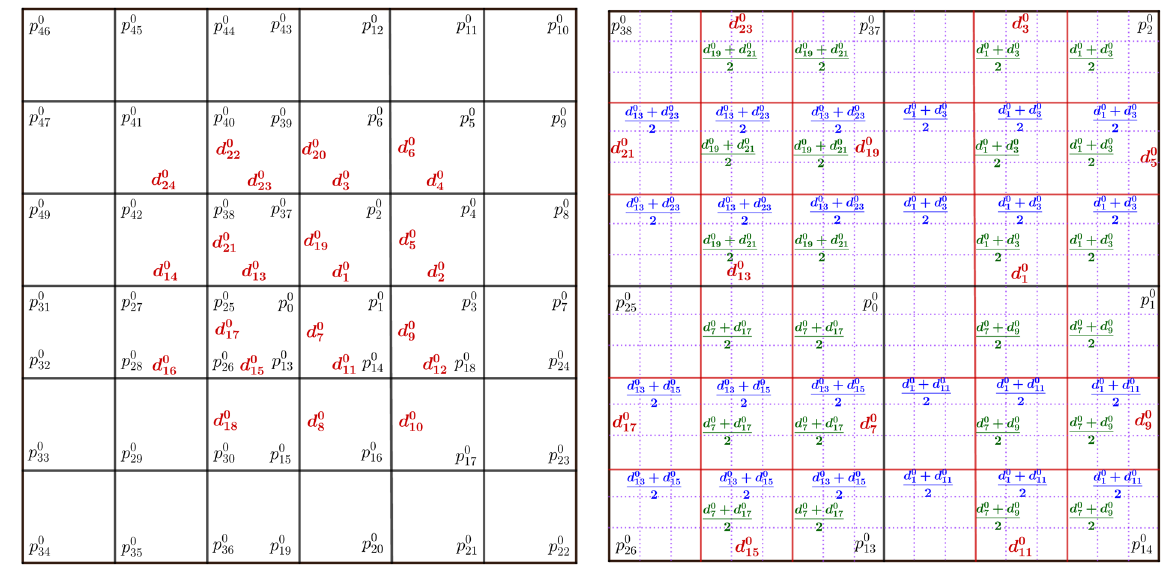
Figure 6. Left: vertex subscript and edge parameter subscript of the initial mesh. Right: edge parameter subscript after two refinement steps.